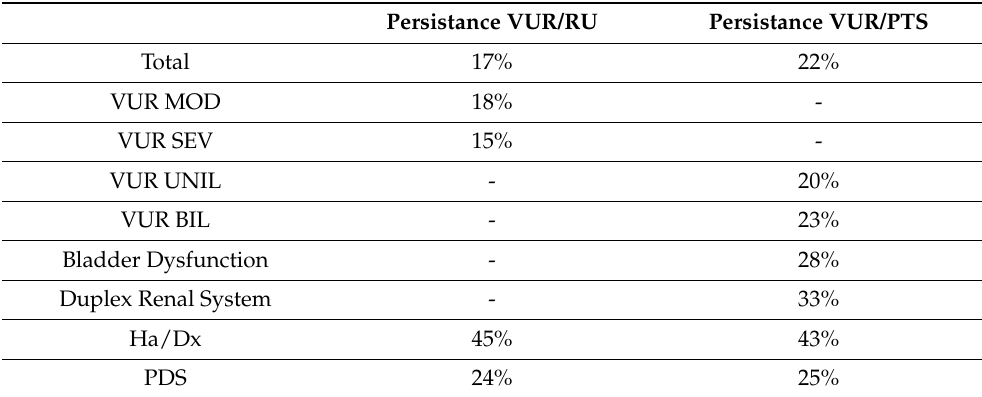
Table 3. Persistence rate at long term follow up in relationship to number of renal unit (RU) and patients